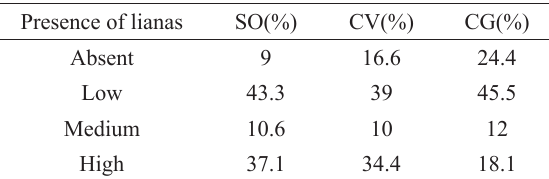
Number of lianas on tree regeneration in the three forest fragments Sooretama (SO, 14 years after fire), Córrego do Veado (CV, 25 years after fire) and Córrego Grande (CG, 25 years after fire), State of Espírito Santo, Brazil. Absent= without any liana/stem, Low= 1 to 5 lianas/stem, Medium = 6 to 10 lianas/stem, High= More than 10 lianas/ stem.